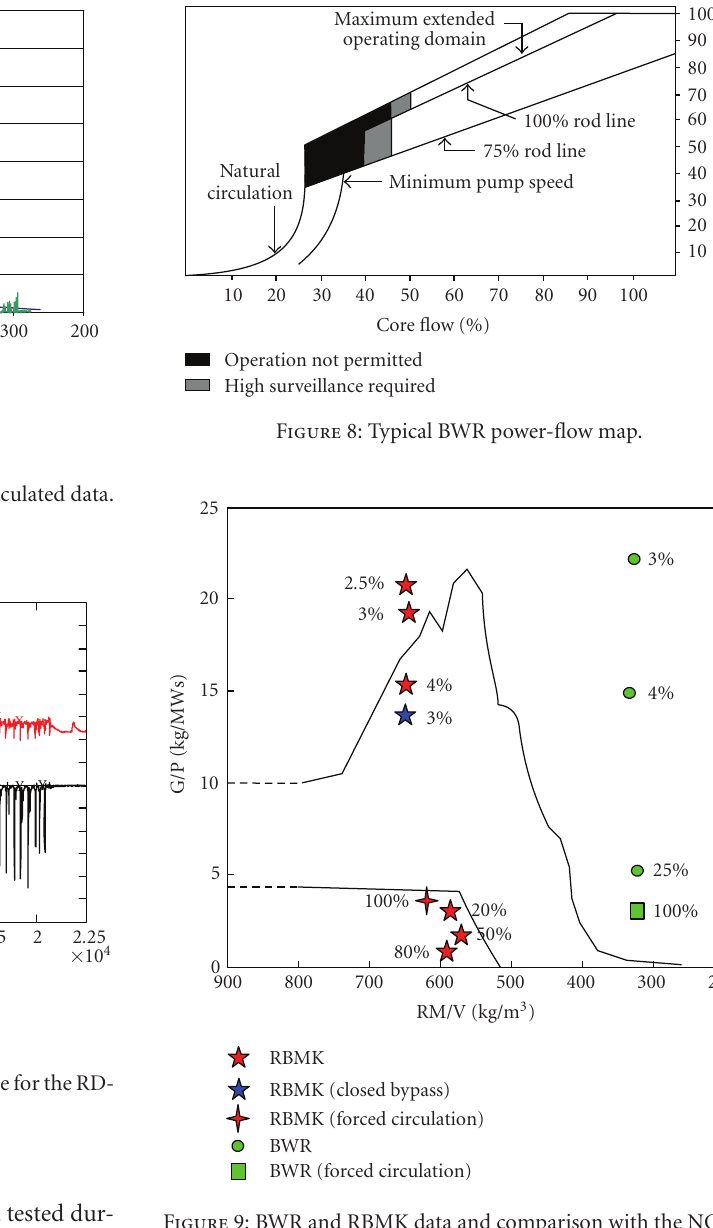
Figure 9: BWR and RBMK data and comparison with the